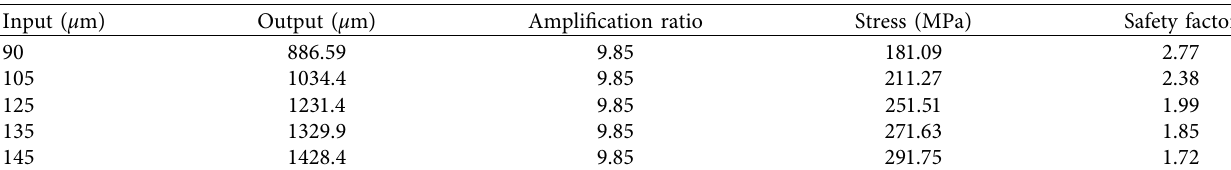
Figure 8: Deformation simulation. Table 3: Results of static